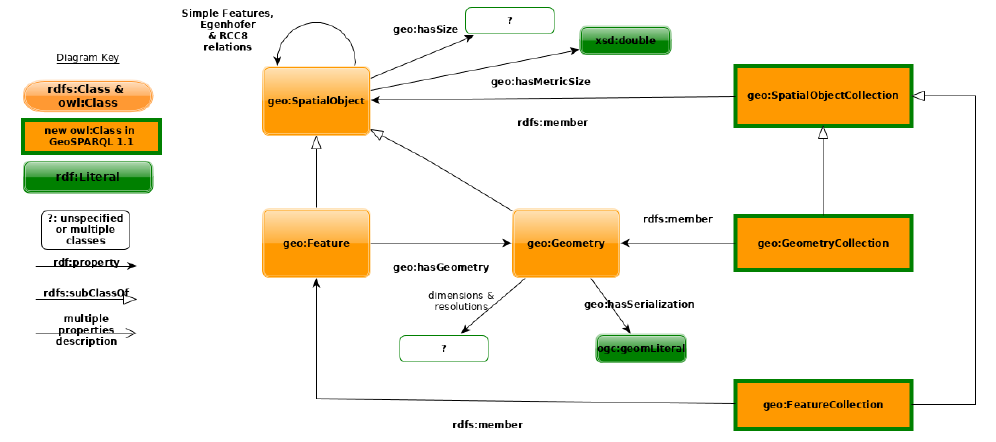
Figure 1. GeoSPARQL 1.1 ontology overview diagram including classes new properties. After GeoSPARQL 1.1’s own overview